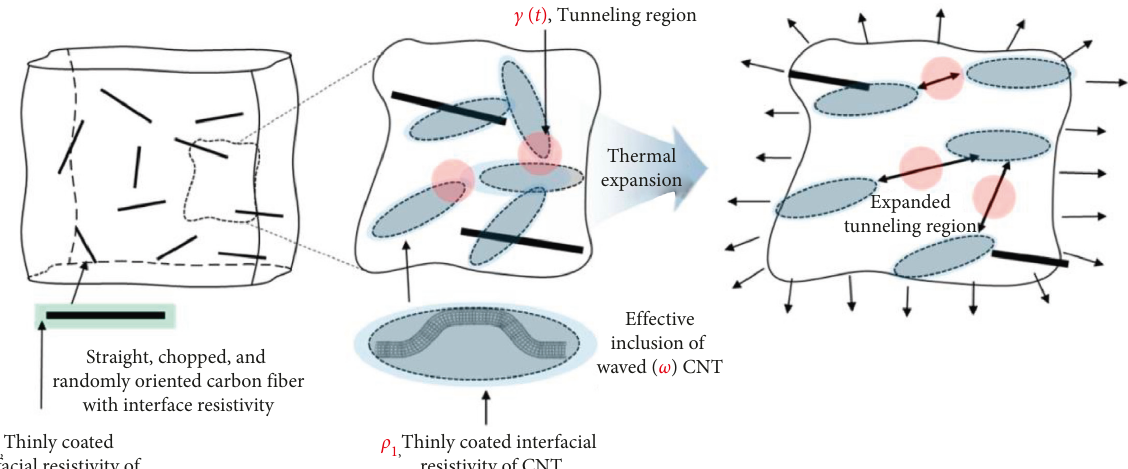
Figure 24: Schematics of the intelligent hybrid fiber concrete (CNT/CF).